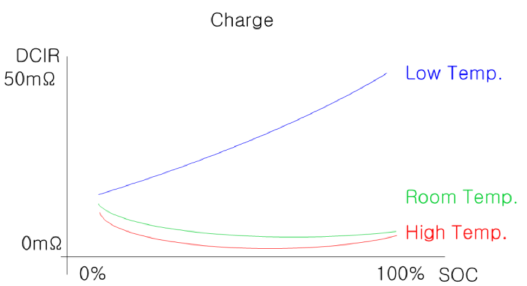
Figure 4. DCIR temperature characteristics during charging of pouch-type Li-polymer